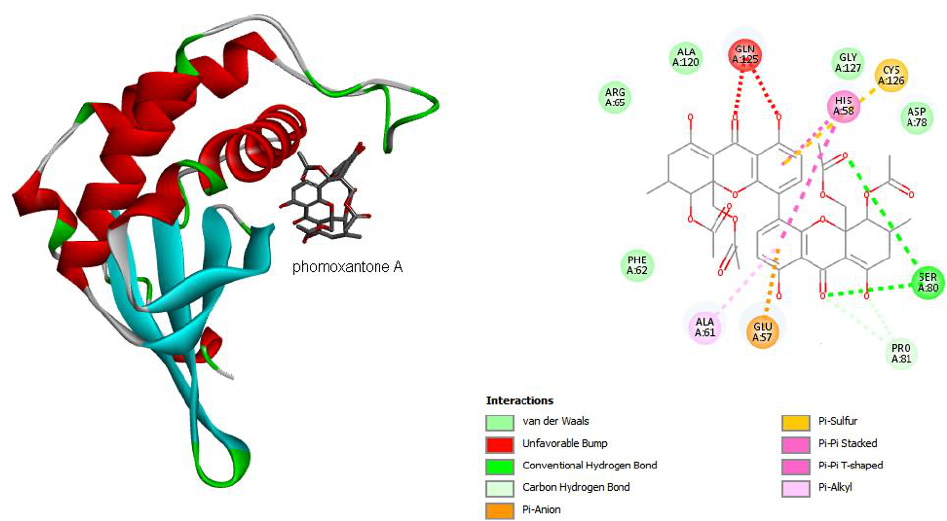
Figure 3. The 3D ( left ) and 2D ( right ) diagrams showing the interactions of phomoxanthone A at the catalytic site of LuxS (PD ID 2FQO). The beta sheets of the protein are represented in cyan blue and the alpha helices in red. The carbon atoms of phomoxanthone A are represented in gray, the oxygen atoms in red, and the hydrogen atoms were suppressed for better visualization of the image. The figure was generated by the Biovia Discovery Studio Visualizer software (v19.1.0.18287, BIOVIA, San Diego, CA, USA).